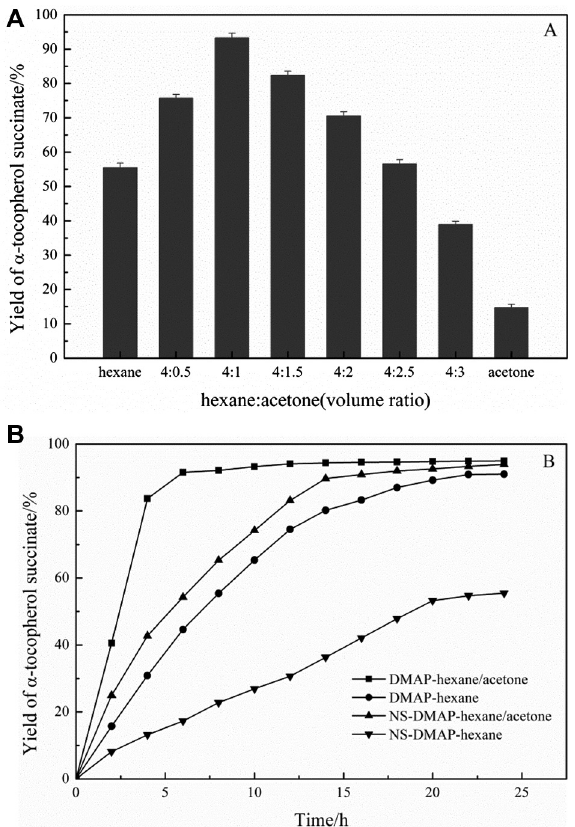
Figure 7: (a) Effect of mixed solvent system; (b) Effect of different catalytic reaction system. Conditions of reaction: 0.15 mmol α-tocopherol, 0.45 mmol succinic anhydride, 0.10 mmol catalyst, hexane/acetone (4 mL/1 mL), 55°C, nitrogen, 16 h.